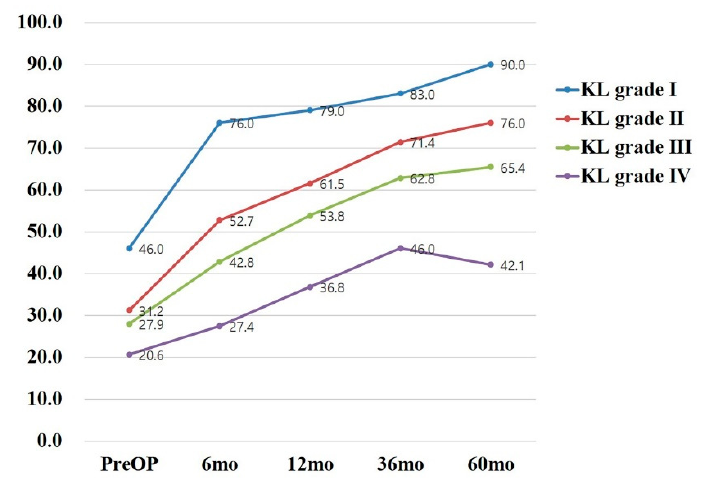
Figure 3. International Knee Documentation Committee (IKDC) score according to the K-L grade.